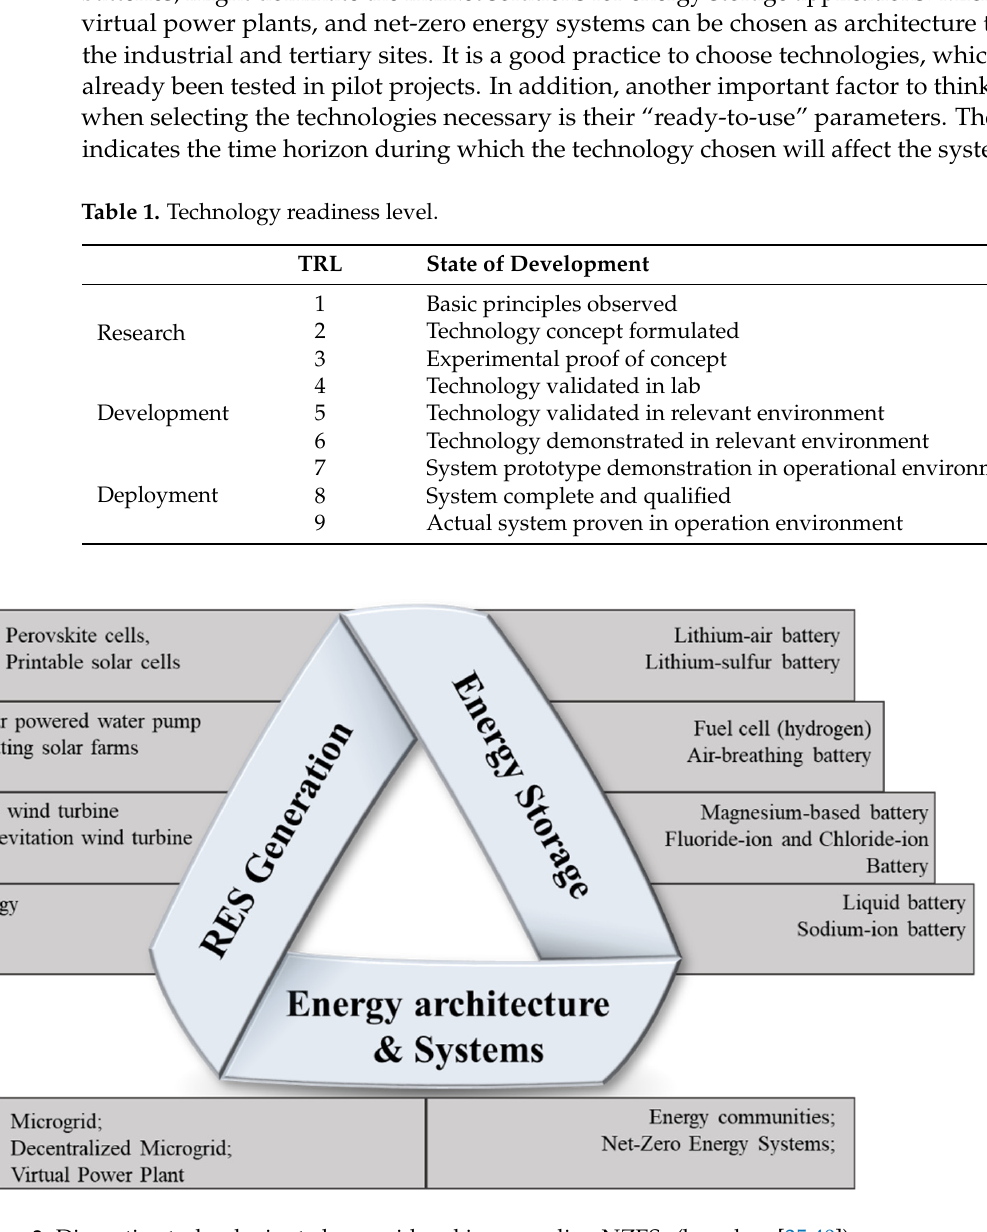
Figure 3. Disruptive technologies to be considered in upgrading NZESs (based on [35,40]).